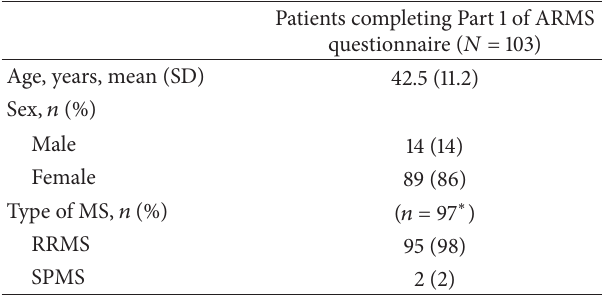
Table 1: Demographic and clinical characteristics of patients. Patients completing Part 1 of ARMS